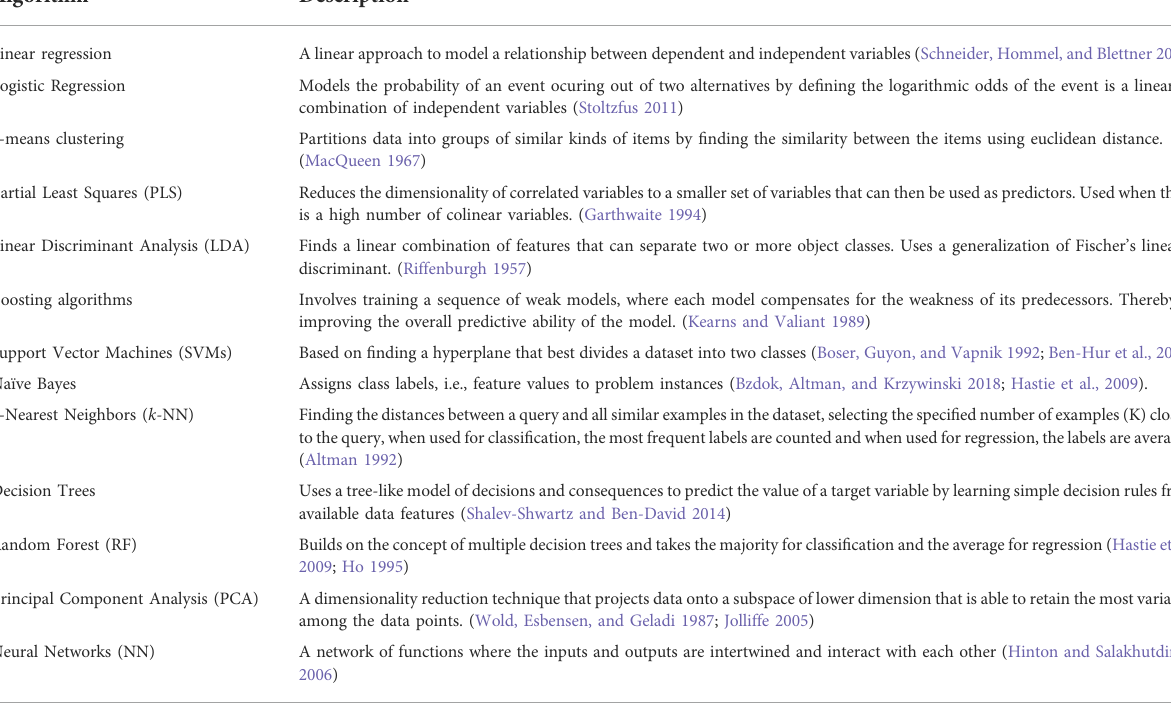
TABLE 1 Key applied machine learning algorithms.